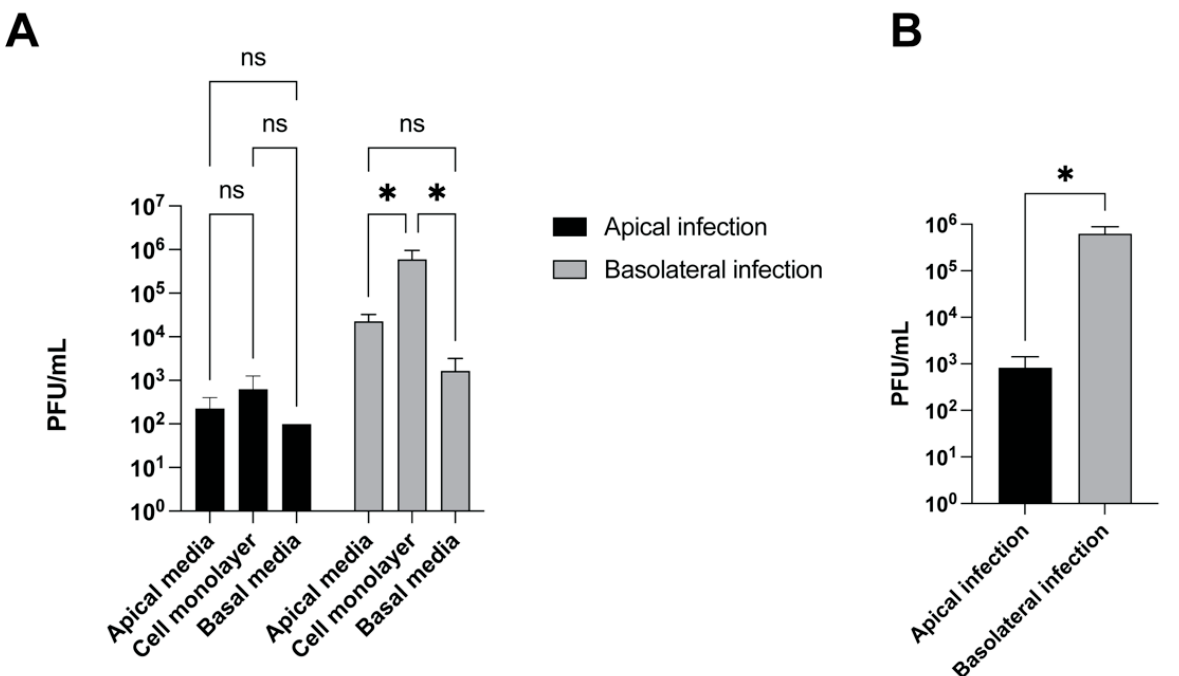
Figure 4. CHV-1 infection is more efficient after basolateral surface inoculation than after apical inoculation. Polarized MDCK cells grown in 12-well plates with trans-well inserts were infected either apically or basolaterally with CHV-1 V777. Virus yield at 24 h.p.i was quantified by viral plaque assay. ( A ) Virus yield for cell culture supernatants in the apical chamber, in the basolateral chamber, and from the cell monolayer were determined. Values represent the averages from two independent experiments each done in duplicate. Error bars show the standard error of the mean. Two-way ANOVA test: * p < 0.05. ( B ) Total virus yield from the three compartments (apical chamber, The results represent the averages of two independent experiments each done in duplicate ( n =